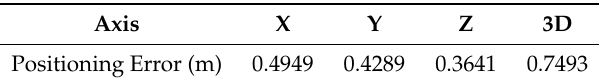
Table 6. Error corrected dynamic positioning